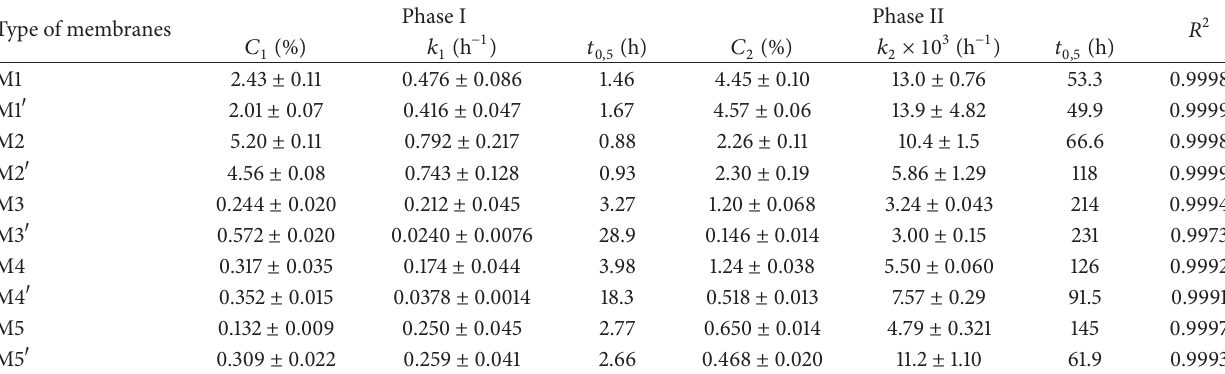
Table 2: Constant values of kinetic equation describing in vitro PDGF-BB release from the membranes, mean ± SD. Type of membranes